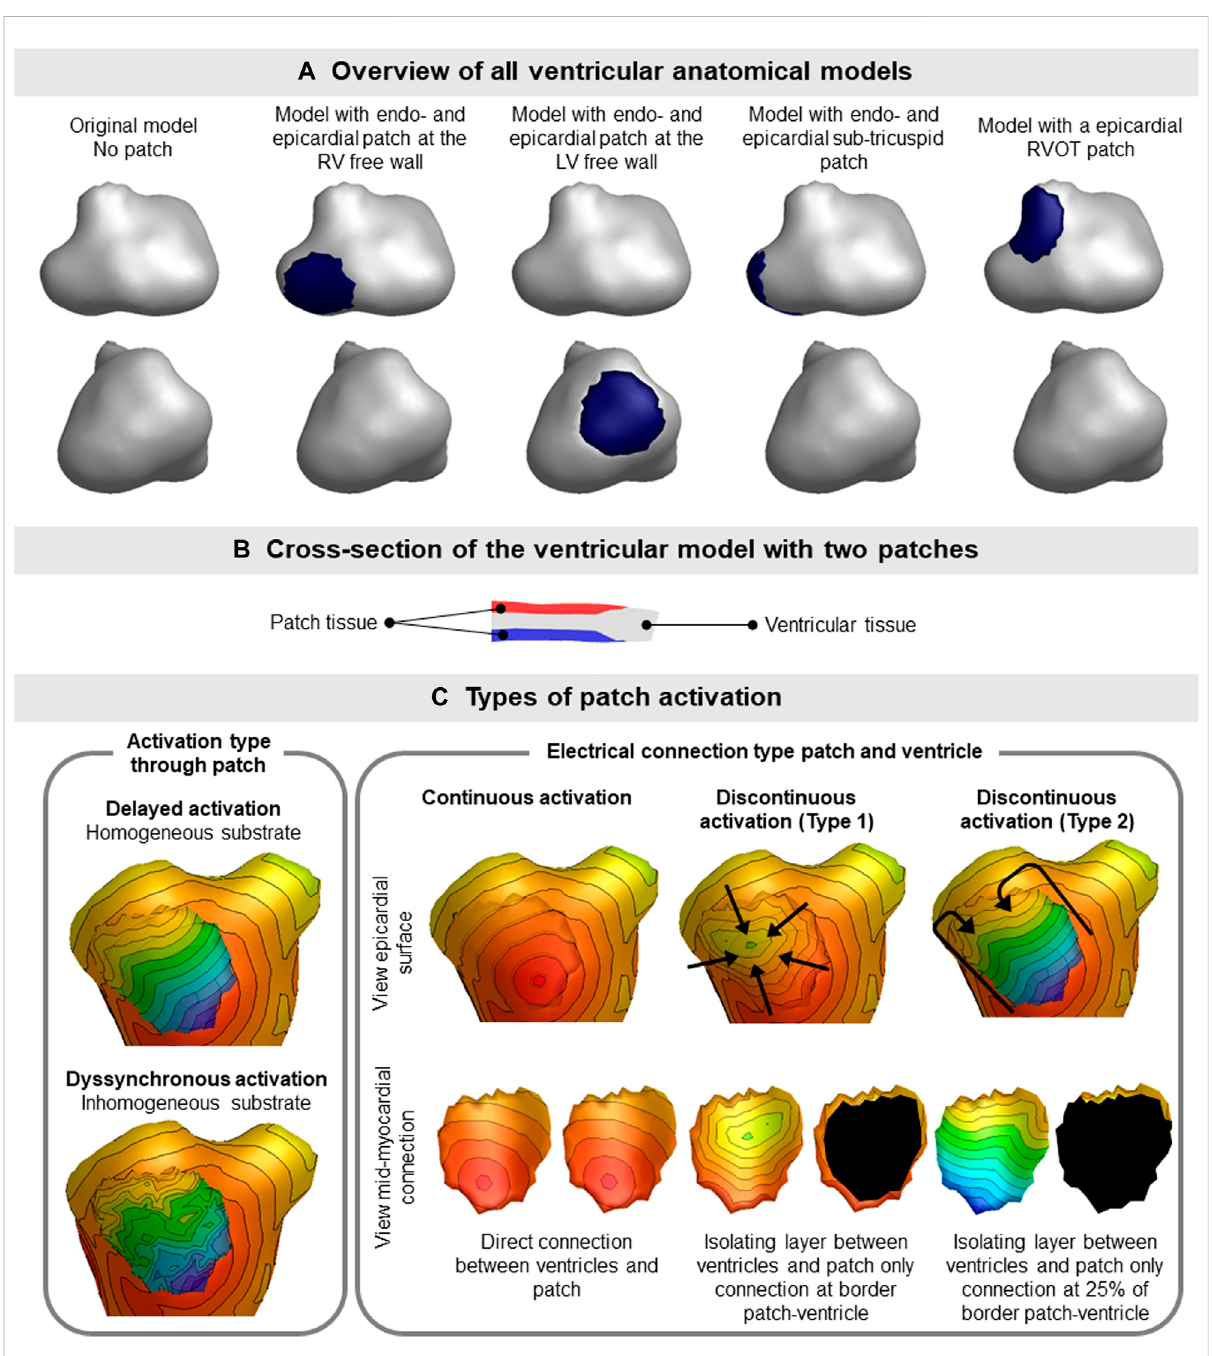
FIGURE 2 Ventricular patch model overview and simulation characteristics. (A) The four different patch locations used for the simulation studies are displayed.Thelocationofthepatchisindicatedbytheblueregionontheepicardium.Whereindicatedwithendo-andepicardialpatch,anopposing endocardialispresentwiththesame size asthedisplayed epicardial patch. (B) Patches(red, endocardialand blue,epicardial) wereembeddedwithin theventriculartissue(gray),therebynotchangingtheoutershapeoftheventricularmodel. (C) Differenttypesofactivationsequences(delayed, dyssynchronous, continuous and discontinuous) of the patches are displayed as local activation timing maps from red (early) to blue (late) with isochrone steps of 10 ms. The isolating layer between the ventricles and patch is indicated in black on the inside of the patch. The ventricular activation sequence of the myocardium (excluding the patch) used in this study was equal for all